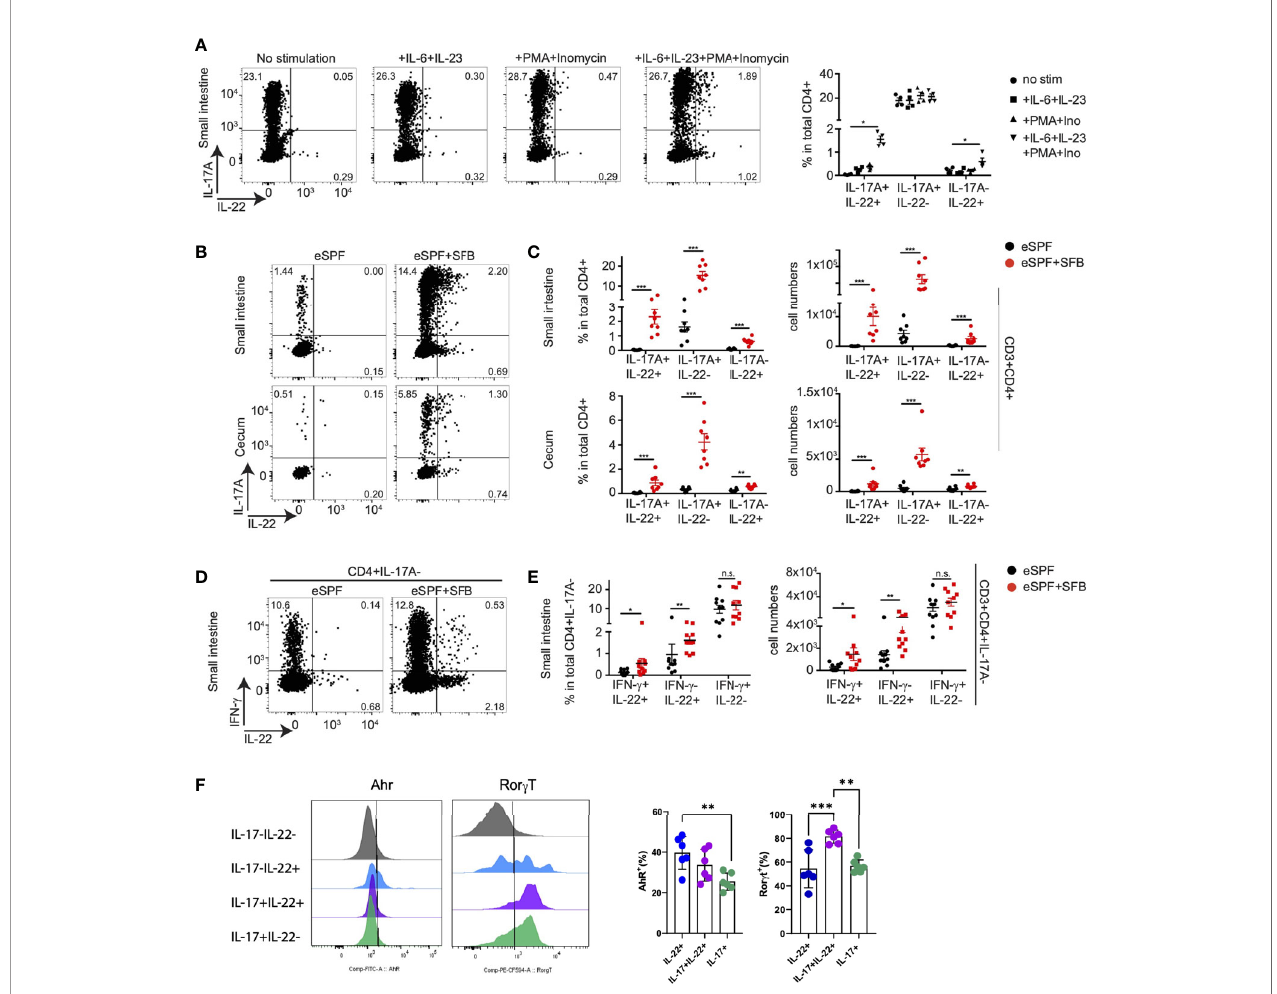
FIGURE 6 | SFB induced CD4 T cells during steady state require cytokine stimulation to secret IL-22. (A) Small intestinal LPL were isolated from baseline of IL-17A GFP IL-22 BFP FoxP3 RFP mice harboring eSPF+SFB. Isolated LPL were stimulated for 5hrs upon indicated conditions and analyzed by FACS. Left, representative FACS plots and right, frequencies of CD3+CD4+ cells expressing IL-17A and IL-22. (B, C) LPL were isolated from baseline of IL-17A GFP IL-22 BFP FoxP3 RFP mice harboring eSPF or eSPF+SFB. Isolated LPL were stimulated for 5hrs in presence of IL-6, IL-23, PMA and ionomycin and analyzed by FACS. Left, representative FACS plots (B) and right, frequencies (C) of CD3+CD4+ cells expressing IL-17A and IL-22. (D, E) LPL were isolated from the baseline of non-reporter (WT) mice harboring eSPF or eSPF+SFB. Isolated LPL were stimulated for 5 h in presence of IL-6, IL-23, PMA, and ionomycin and analyzed by FACS for intracellular cytokine production. Left, representative FACS plots (D) and right, frequencies (E) of CD3+CD4+IL-17A- cells expressing IFN- g and IL-22. (F) LPL were isolated from the baseline of non-reporter (WT) mice harboring eSPF+SFB. Isolated LPL were stimulated for 5 h in the presence of IL-6, IL-23, PMA, and ionomycin and analyzed by FACS for transcription factor and cytokine production. Left, representative FACS plots gated on the indicated subsets of CD4+ T cells and right, frequencies of transcription factor positive cells within the indicated subsets. Data represent n = 4 – 8 mice/group as mean ± SEM from at least two independent experiments. P-values indicated represent an unpaired Student ’ s t test *p < 0,05; **p < 0,01; ***p < 0,001; n.s., not signi fi cant. See also Supplementary Figure S6